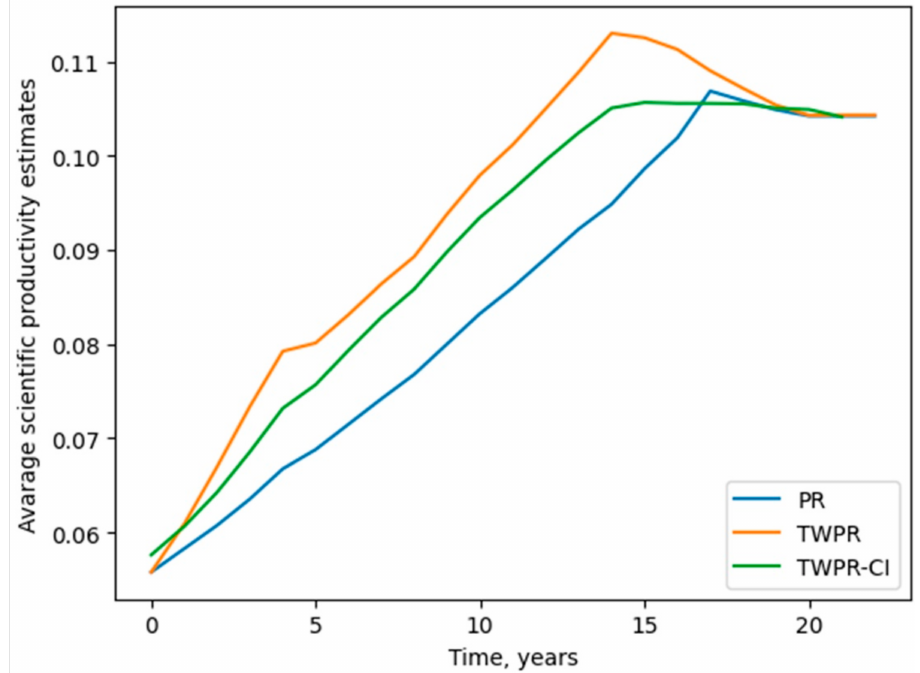
Figure 4. A graph comparing the scientific productivity estimates of collective subjects belonging to the WK class by the methods of PR (6), TWPR (6), (8), β = 0, TWPR-CI (6), (8), β = 1